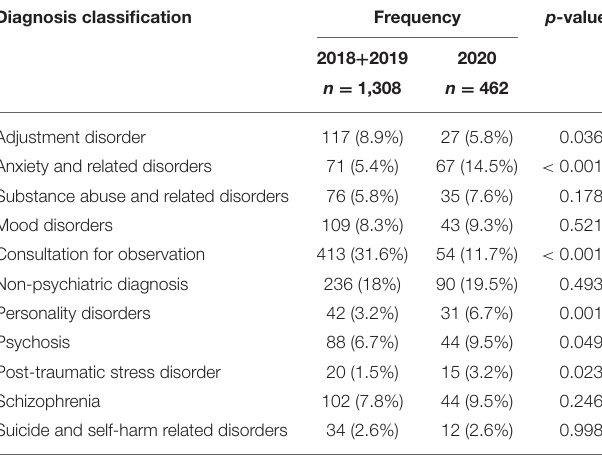
TABLE 1 | The numbers and proportions of patients with each of 11 diagnostic classifications during March-April 2018–2019 and during March-April 2020 (the COVID-19